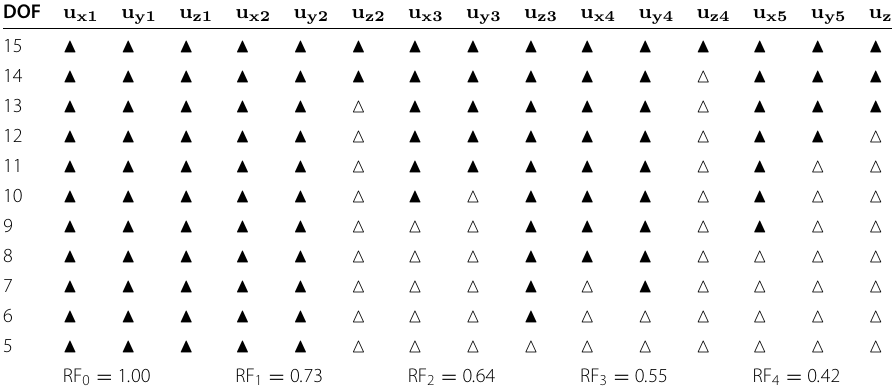
Table 13 BTD models, 0/90/0/90, a/h = 50